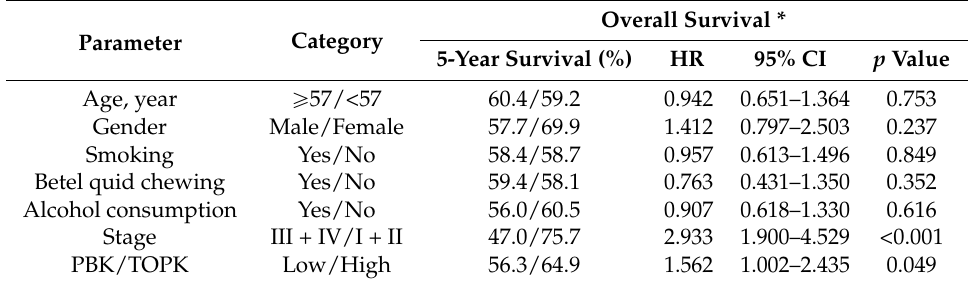
Table 3. Multivariate analysis of the influence of clinicopathological parameters on the overall survival of oral cancer